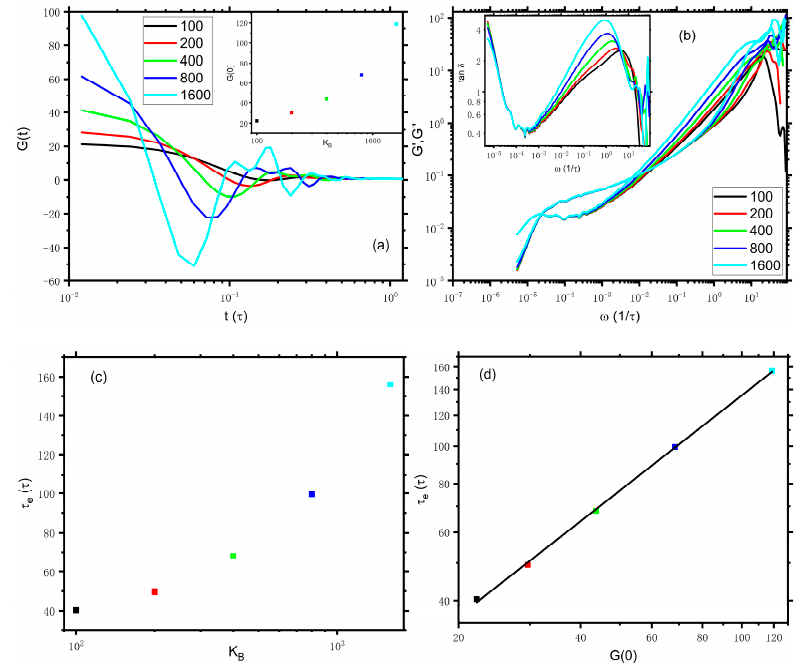
Figure 4. ( a ) Stress relaxation of N = 129 for different spring constants, K B , ranging from 100 to 1600 at an early time. The value of G ( 0 ) is shown in the inset. ( b ) The corresponding viscoelastic moduli. The absolute values of G ( t ) are input into i-Rheo GT . The inset presents the tan δ vs. frequency curves. ( c ) Dependence of the entanglement time τ e on the spring constant K B . ( d ) Dependence of the entanglement time τ e on the values of G ( 0 ) of different spring 3.2. KG